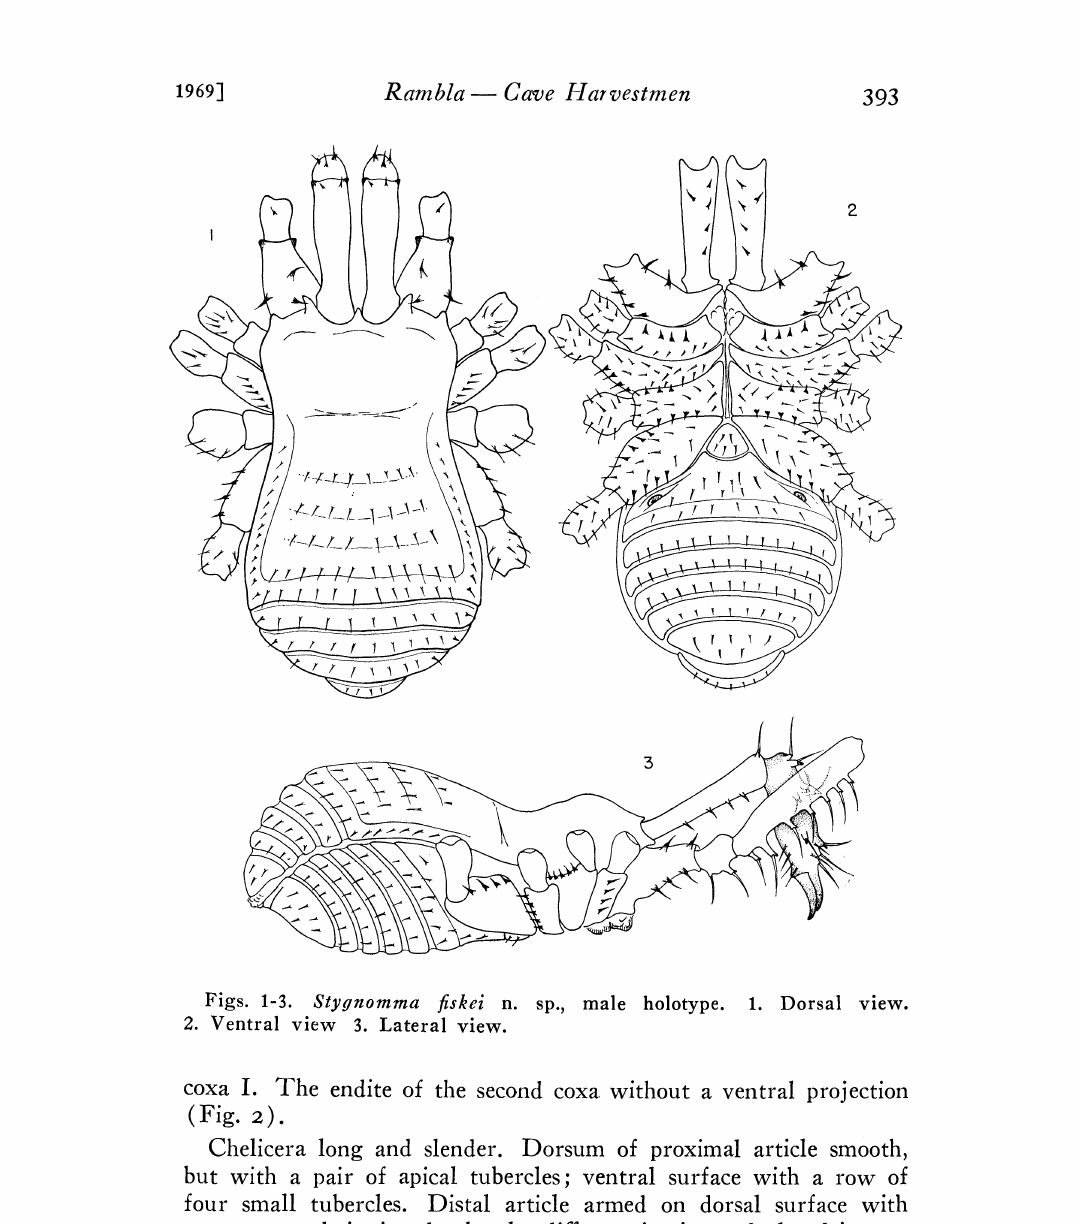
Figs. 1-3. Stygnomma fiskei n. sp., male holotype. 1. Dorsal view. 2. Ventral view 3. Lateral